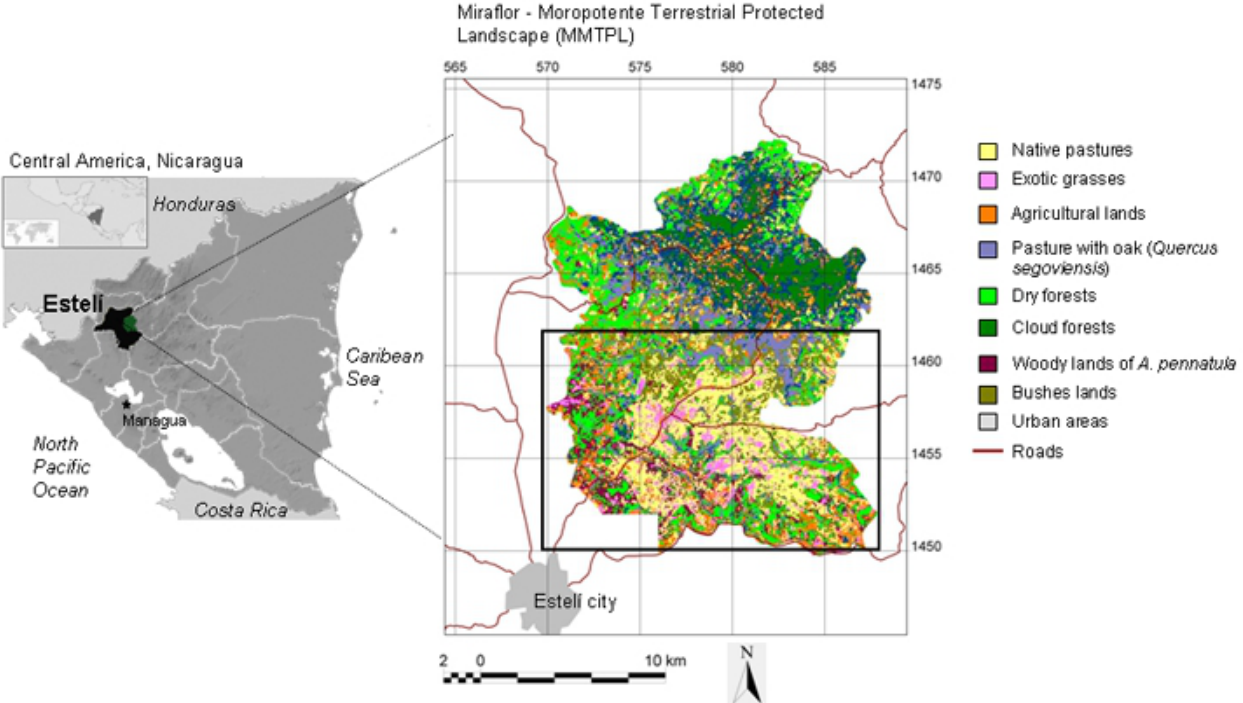
Fig. 1. Map of the Miraflor–Moropotente Terrestrial Protected Landscape and land cover in 2008. The study area is located in the semiarid zone (within the black